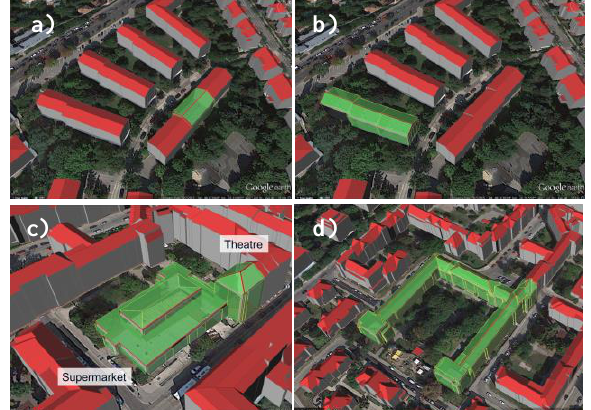
Figure 7. Highlighted in green: a) a correctly modelled building; b) 3 similar residential buildings wrongly grouped into a single building; c) 2 different buildings wrongly grouped into a single building; d) a building “agglomerate” deriving from one